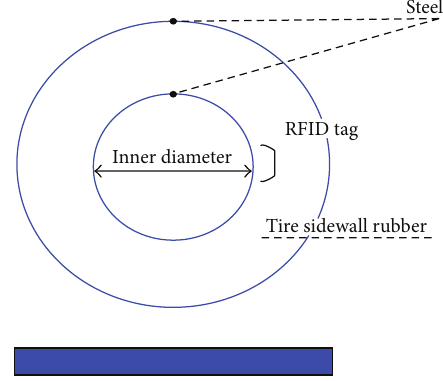
Figure 3: The RFID tag embedded in tires.